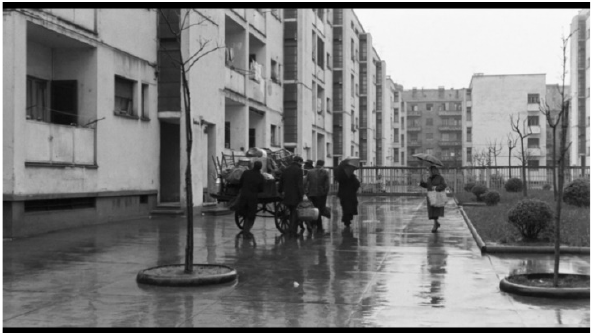
Figure 14 Screenshot from Rocco and His Brothers. (Goffredo